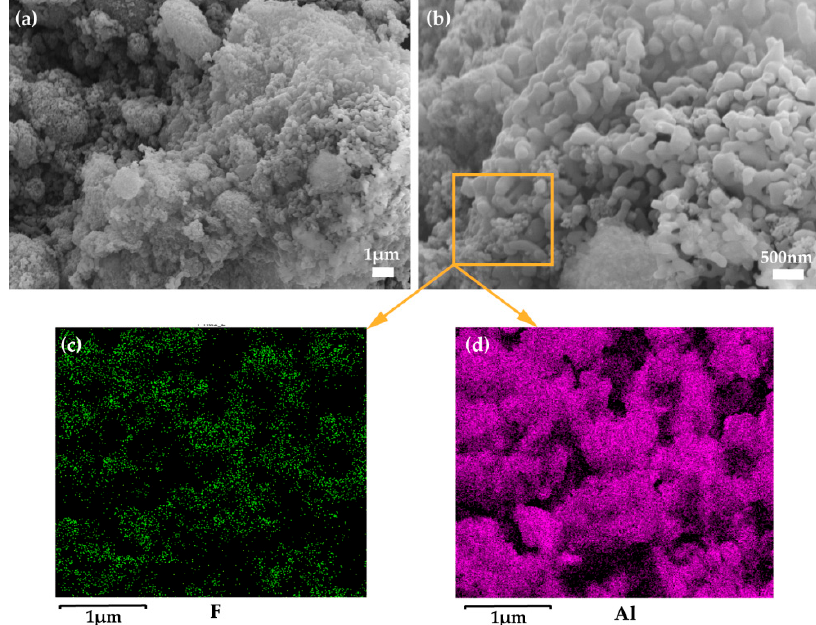
Figure 1. ( a , b ) Scanning Electron Microscope (SEM) images of a treated surface in different scales and Energy Dispersive Spectroscopy (EDS) distribution maps of ( c ) fluorine and ( d ) aluminum.